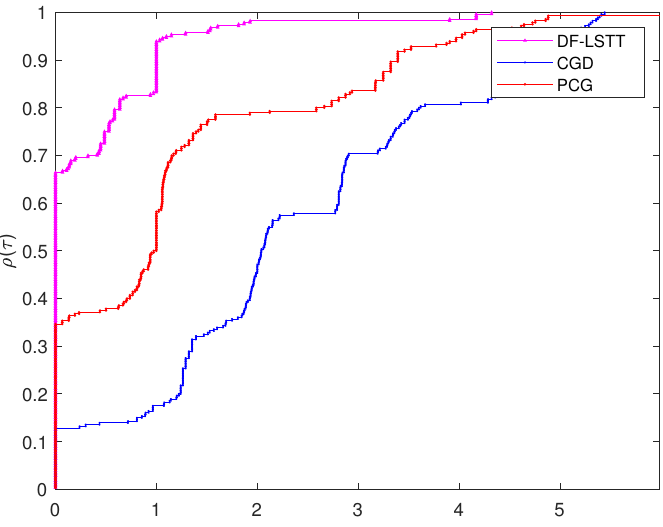
Figure 6. Performance of compared methods relative to the number of